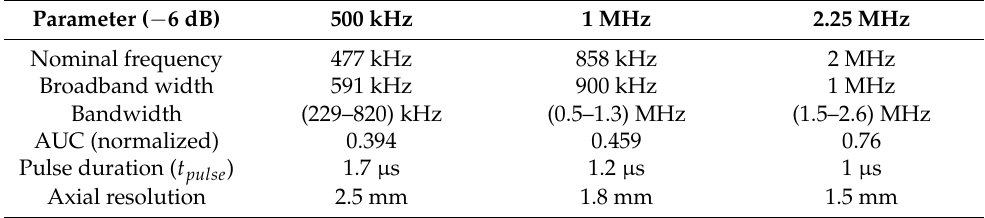
Table 2. Time and frequency ( − 6 dB) parameters of the transmitted signal, generated using the pulse-receiver generator and recorded using a 0.5 mm needle hydrophone; f 0 = 500 kHz, 1 MHz, 2.25 MHz ( c 0 = 1486 m/s). Parameter ( − 6